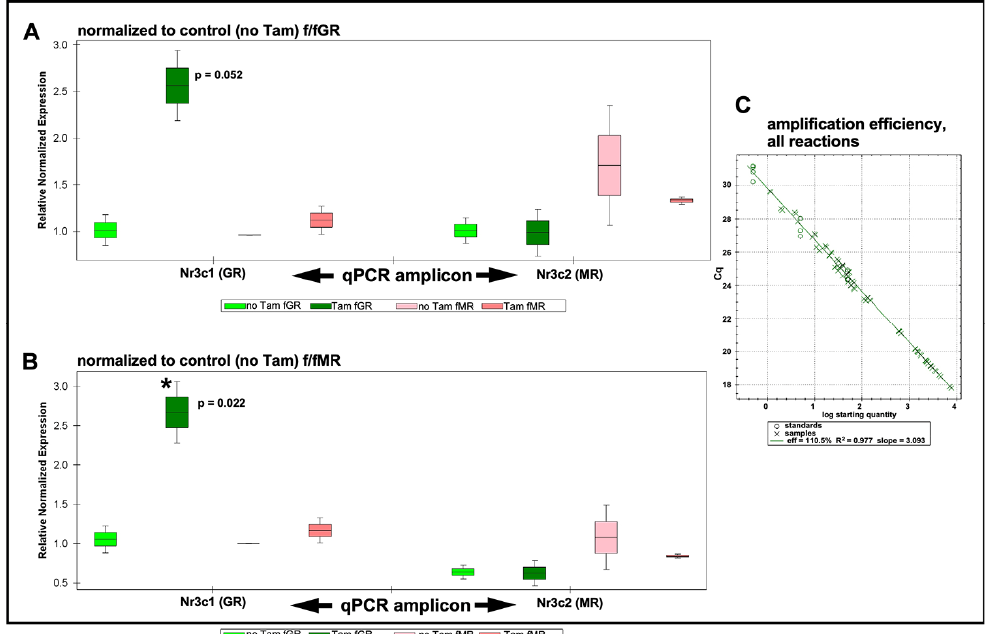
Figure 2. qRT ‐ PCR results. Expression levels are grouped by target gene as assessed in each mouse line and with either the GR or MR serving as normalizer. ( A ) qRT ‐ PCR results are normalized to the control (no tamoxifen) expression level of GR. Following tamoxifen treatment, Nr3c1 (GR) expression (green bars) is increased approximately 2.6 × . When normalizing to GR this trend lies just outside standard statistical significance ( p = 0.052), but when normalizing to MR, this increased GR expression is significant ( p = 0.022). Expression of Nr3c2 is slightly elevated (pink bars) when normalized to Nr3c1 control (no tamoxifen). Expression of Nr3c2 is slightly (approximately 16%) decreased following tamoxifen treatment. No change was observed in Nr3c1 expression level under these conditions. ( B ) Similar trends as described when normalizing results to Nr3c1 in ( A ) were observed when normalizing data to Nr3c2. Up ‐ regulation of Nr3c1 was statistically significant (asterisk). ( C ) The amplification efficiency for all sample reactions (X symbols), including reference genes (circles), is plotted. Average amplification efficiency was 110.5%. See Supplementary Materials Figures S4 and S5 for PCR subject group design and analysis plots of individual biological repeats. Boxes indicate mean with upper and lower quartiles; whiskers indicate SEM.